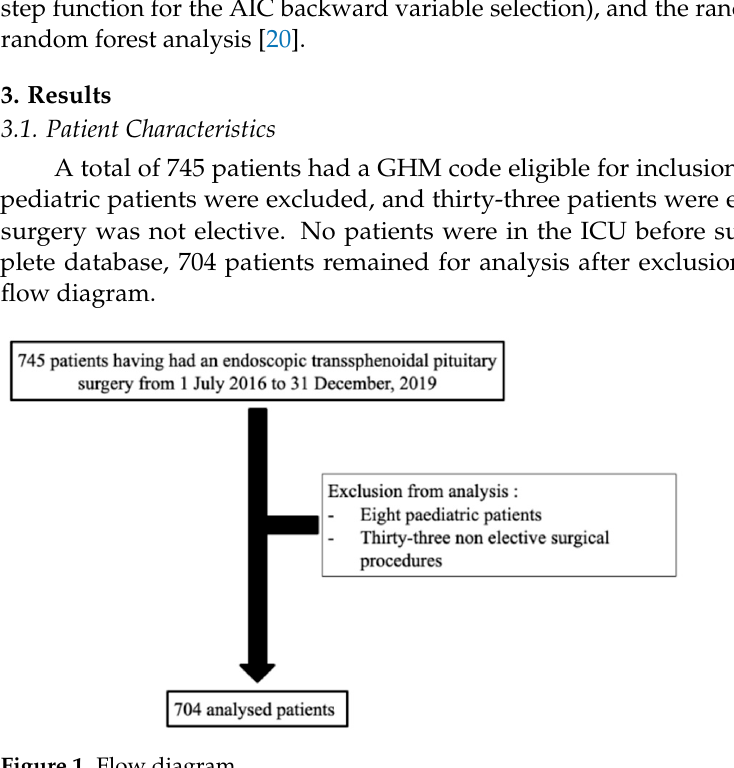
Figure 1. Flow Figure 1. Flow diagram.